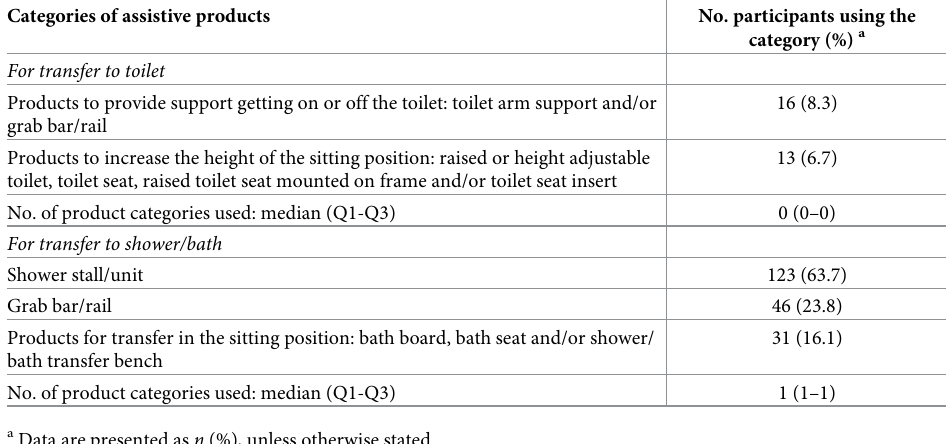
Table 1. Use of assistive products for the transfers in the bathroom area ( n =